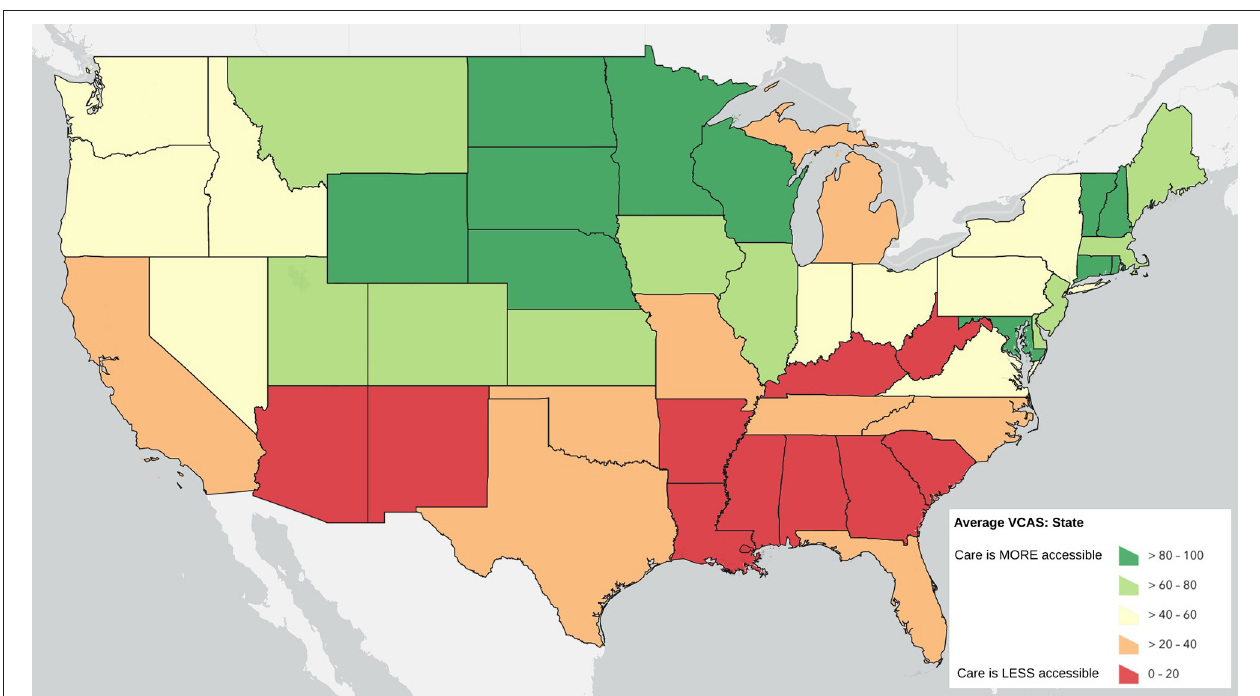
FIGURE 2 | State Average Veterinary Care Accessibility Score by quintile.